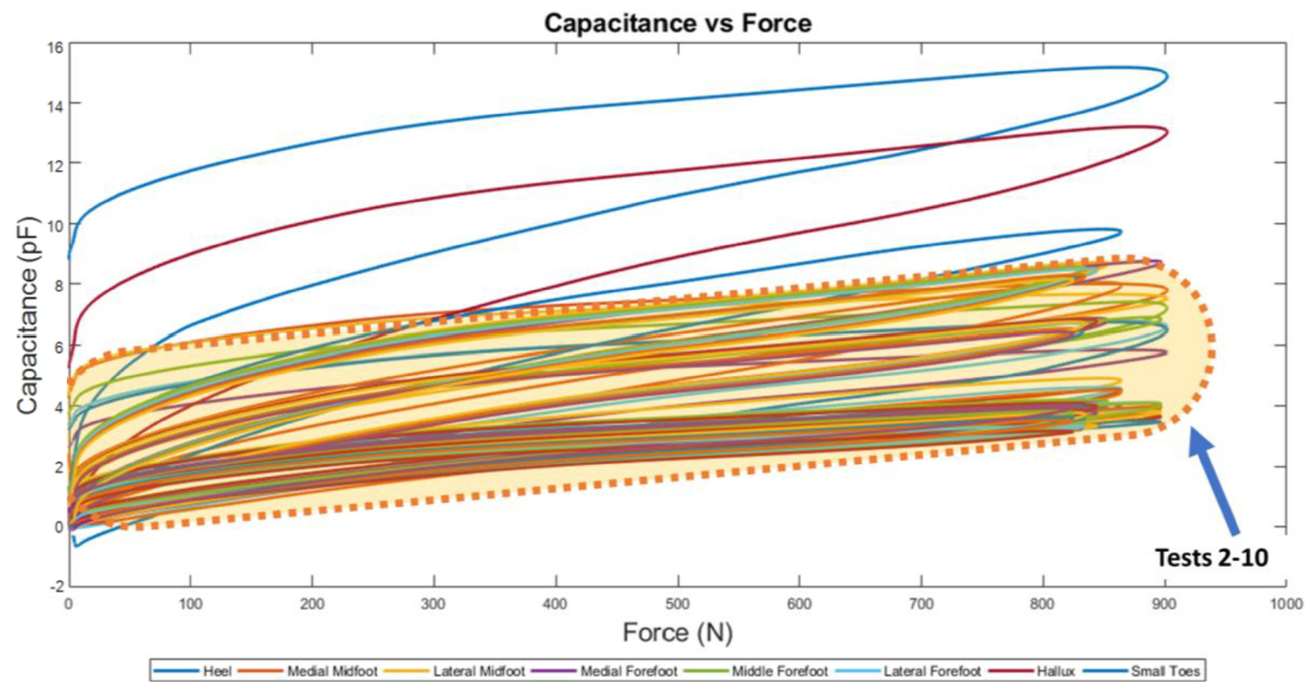
Figure 18. Capacitance and Force Plot for 10